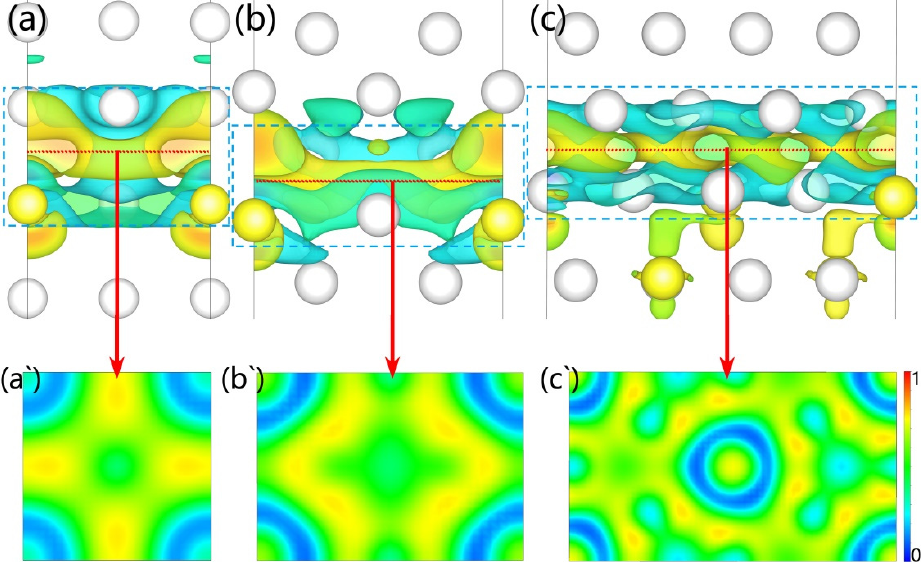
Figure 5. Deformation charge density ( a – c ) and ELF ( a` – c` ).